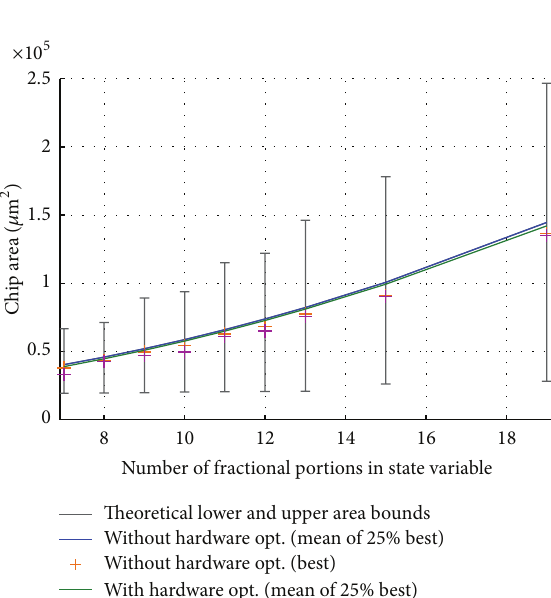
Without hardware opt. (best)